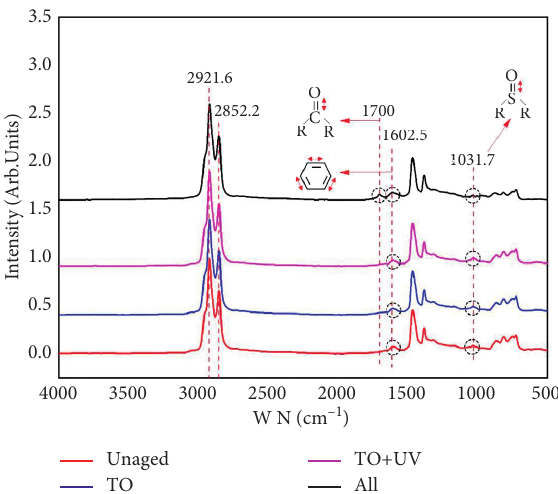
Figure 7: FTIR spectrum of asphalt binder before and after natural